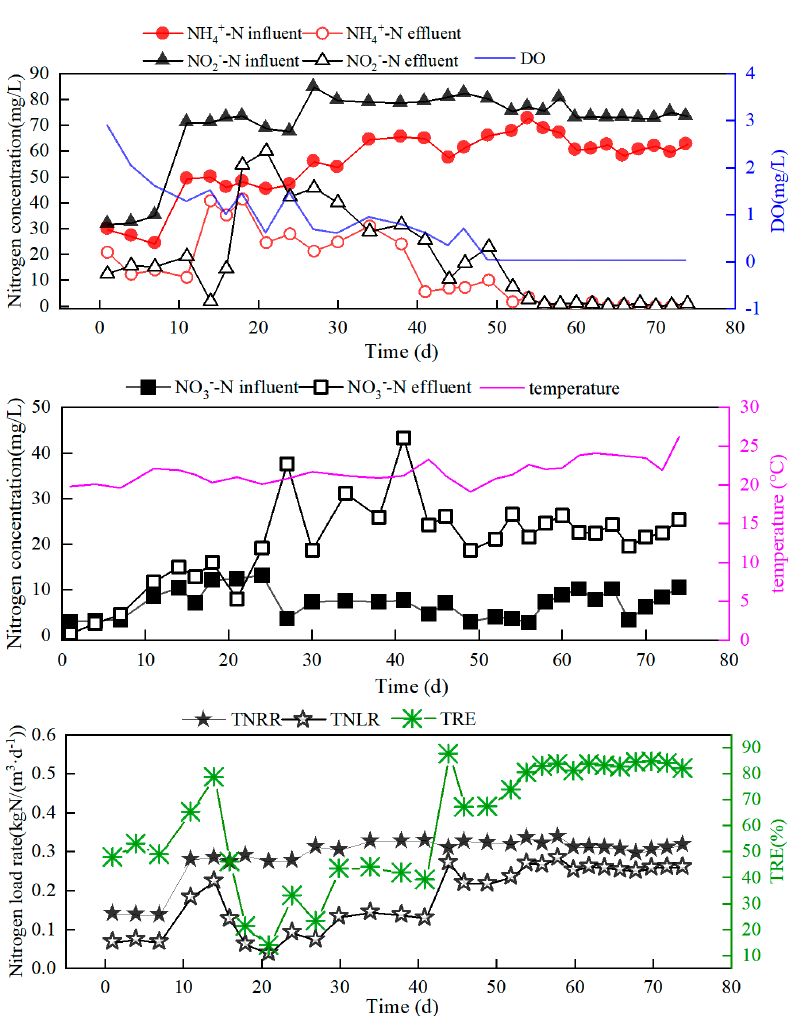
Figure 4. Variations of water quality and nitrogen removal efficiency during the ANAMMOX start- up stage.